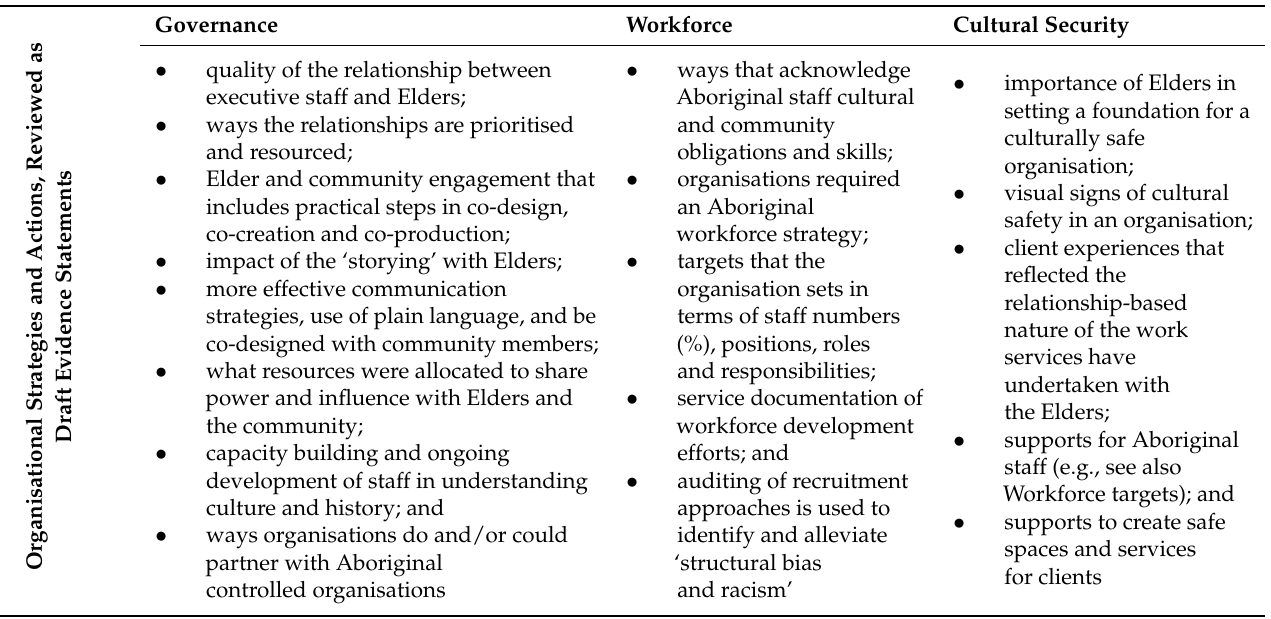
Table 1. Strategies and actions reviewed as “draft evidence statements” grouped under the themes of governance, workforce and cultural security, devised during the earlier 2018 working